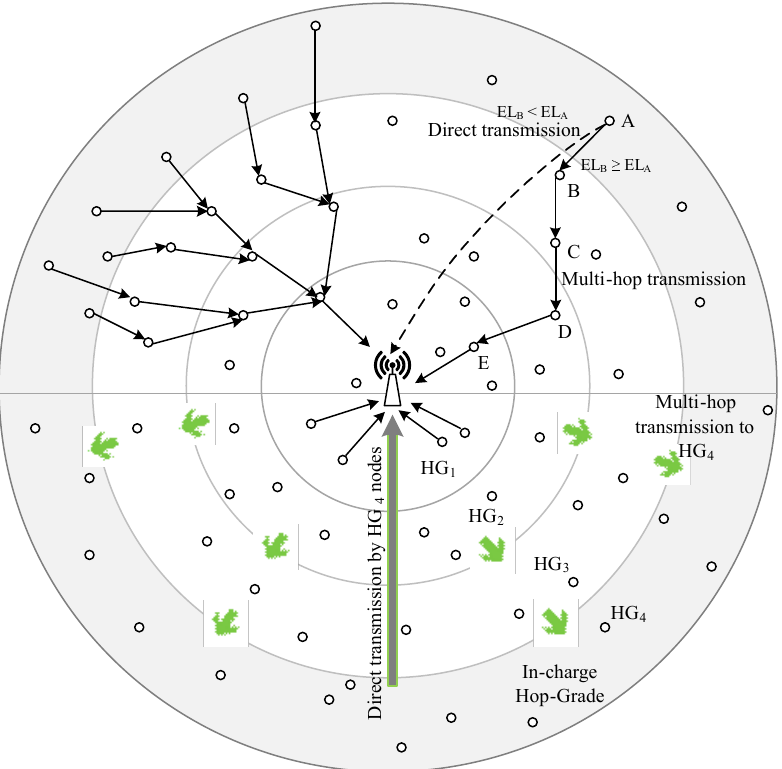
Figure 2. Data transmission in BTM and